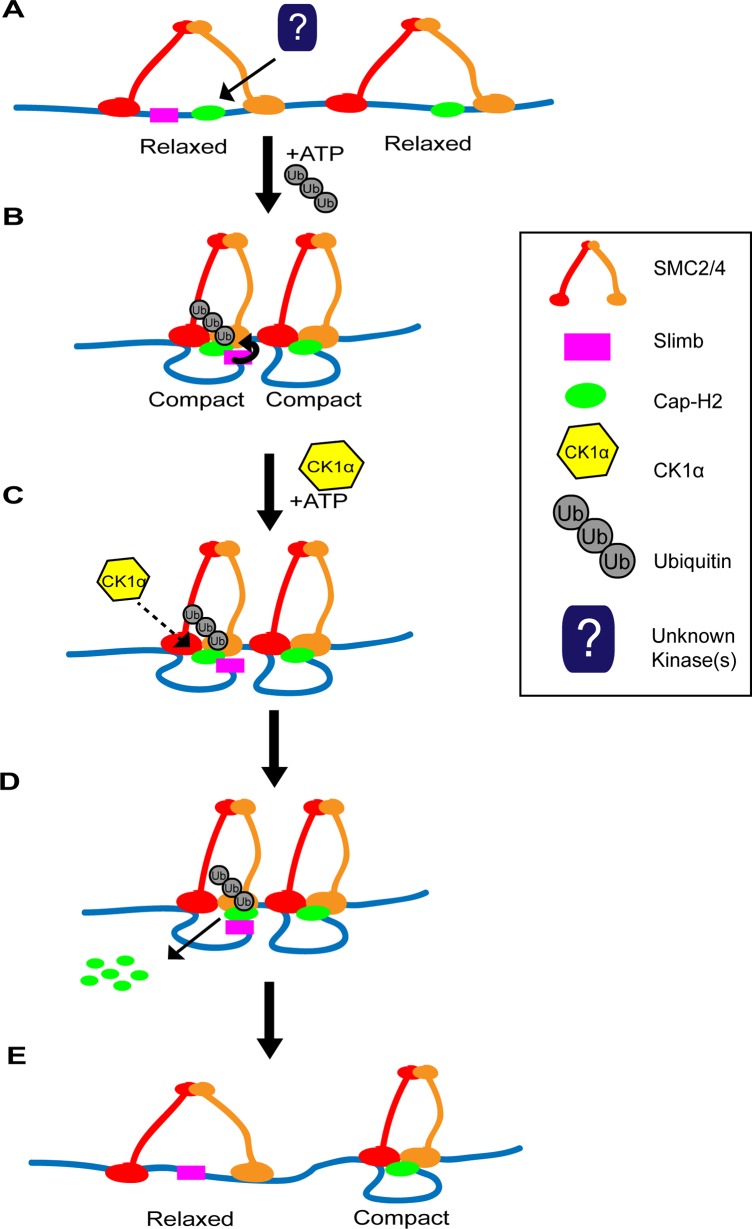
Two-step model of Cap-H2 eviction from chromatin.(A) SMC dimers (red and orange) are associated with DNA (blue line) in the “open” conformation, resulting in “relaxed” chromatin. There may be regions where Cap-H2 (green oval) is bound with or without Slimb (magenta square) nearby. (B) ATP binding to SMC dimers promotes the “closing” of the SMC subunits, resulting in the “compaction” of chromatin. Cap-H2 binding to SMC dimers traps a closed SMC2/4 dimer and inhibits ATP hydrolysis. Inhibition of ATP hydrolysis by Cap-H2 is thought to maintain SMC dimers in the “closed” conformation and promotes axial chromosome compaction. (C) CK1α negatively regulates Cap-H2. This may occur by directly phosphorylating Cap-H2 or indirectly by CK1α targeting an unknown regulator of Cap-H2. (D) CK1α promotes Cap-H2 removal from chromatin and degradation. Note that Slimb interaction with Cap-H2 is not likely to be dependent on CK1α activity. In chromatin regions where Slimb and CK1α are absent (condensin II complex on the right), Cap-H2 could remain on the chromatin, as it avoids Slimb and CK1α mediated degradation. (E) Cap-H2 removal from chromatin results in the opening of the SMC dimer, resulting in the “relaxation” of chromatin (left side), whereas on chromatin where Slimb is absent, Cap-H2 remains chromatin bound and the chromatin remains axially compact (right side).